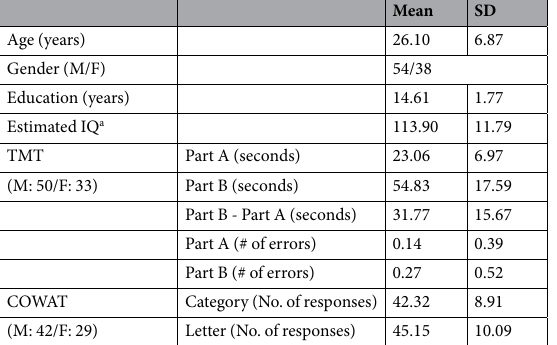
Table 1. The statistics for the demographic and cognitive characteristics of the study sample. IQ: Intelligence quotient, TMT: Trail Making Test, M: Male, F: Female, COWAT: Controlled Oral Word Association Test. a Estimated IQ was measured by the short form of the